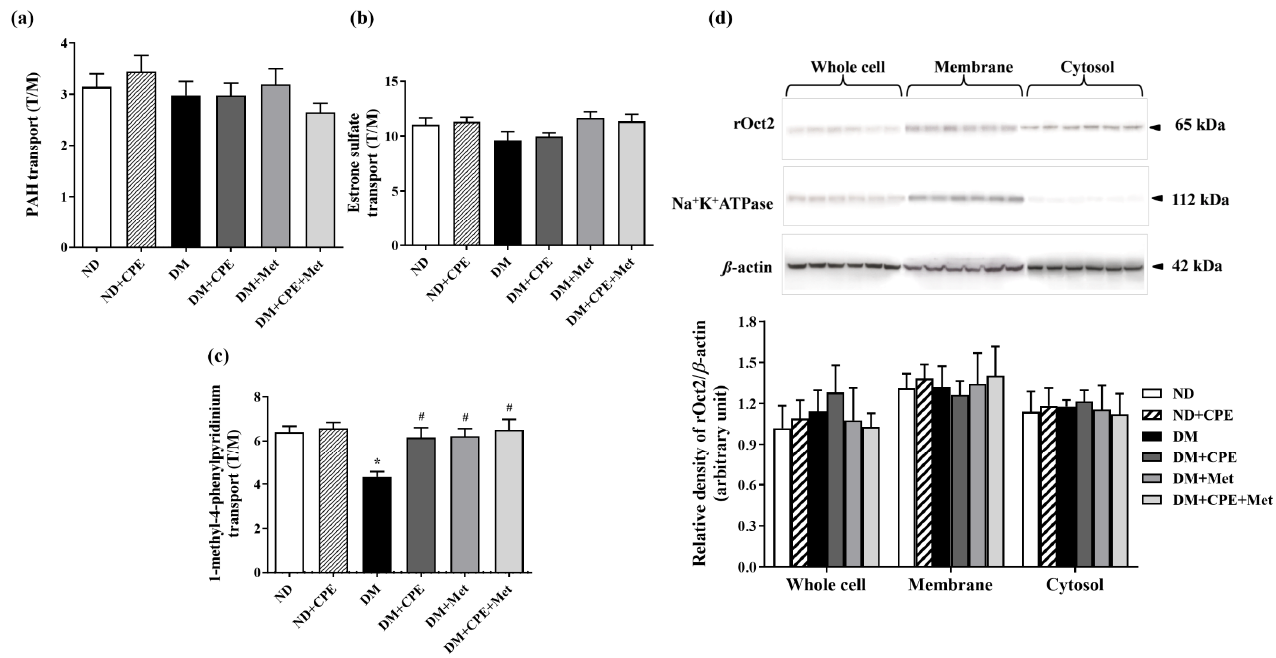
Figure 3. Effect of CPE on ( a ) para -aminohippurate transport mediated by rOat1 and 3, ( b ) estrone sulfate transport mediated by rOat3, and ( c ) 1-methyl-4-phenylpyridinium transport mediated by rOct2 in T2D rats. Data are expressed as tissue to medium ratios (T/M), i.e., tissue content (dpm/mg) ÷ medium (dpm/ µ L). Each experiment was performed in separate animals using 3 slices from each animal ( n = 5–6). * p < 0.05, significantly different from ND; # p < 0.05, significantly different from DM. ( d ) Effect of CPE on rOct2 protein expression from rat kidney cell lysate, membrane, and cytosolic fractions, respectively. Anti-rOct2 antibody was detected at 65 kDa. Anti-Na + -K + -ATPase antibody at 112 kDa and anti- β -actin antibody at the 42 kDa were used as a membrane marker and loading control, respectively. Data are expressed as mean ± S.E.M. and repeated in separate animals ( n = 4–5). A representative blot of rOct2 is shown in the top panel, and quantification of relative protein expression in each fraction is shown in the bottom panel.